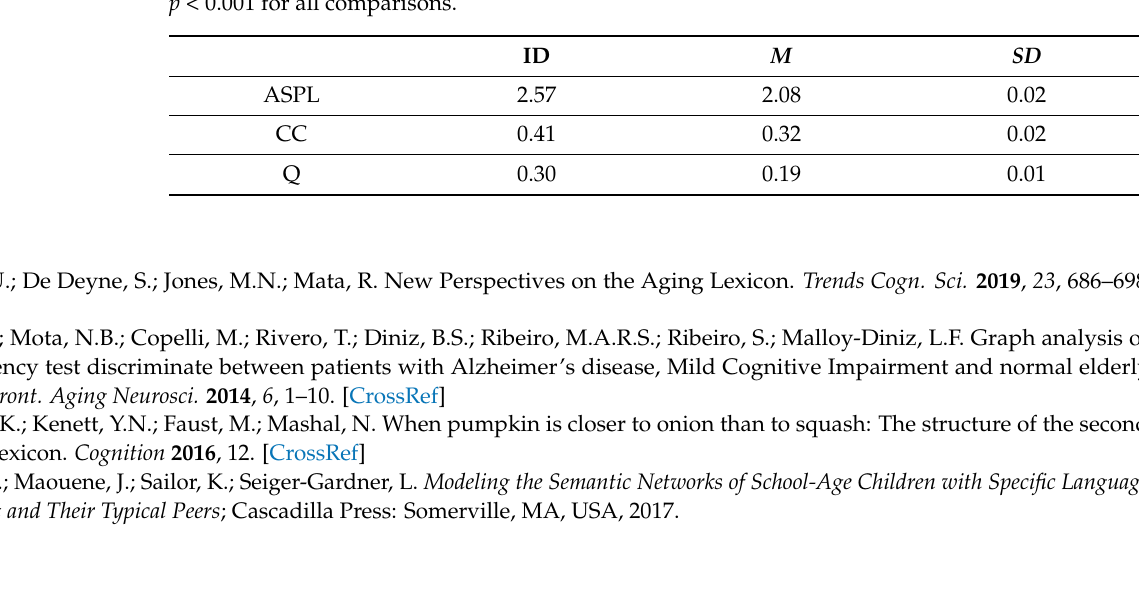
Table A11. Random Network comparison for the network of the adolescents with ID (dataset 10), p < 0.001 for all